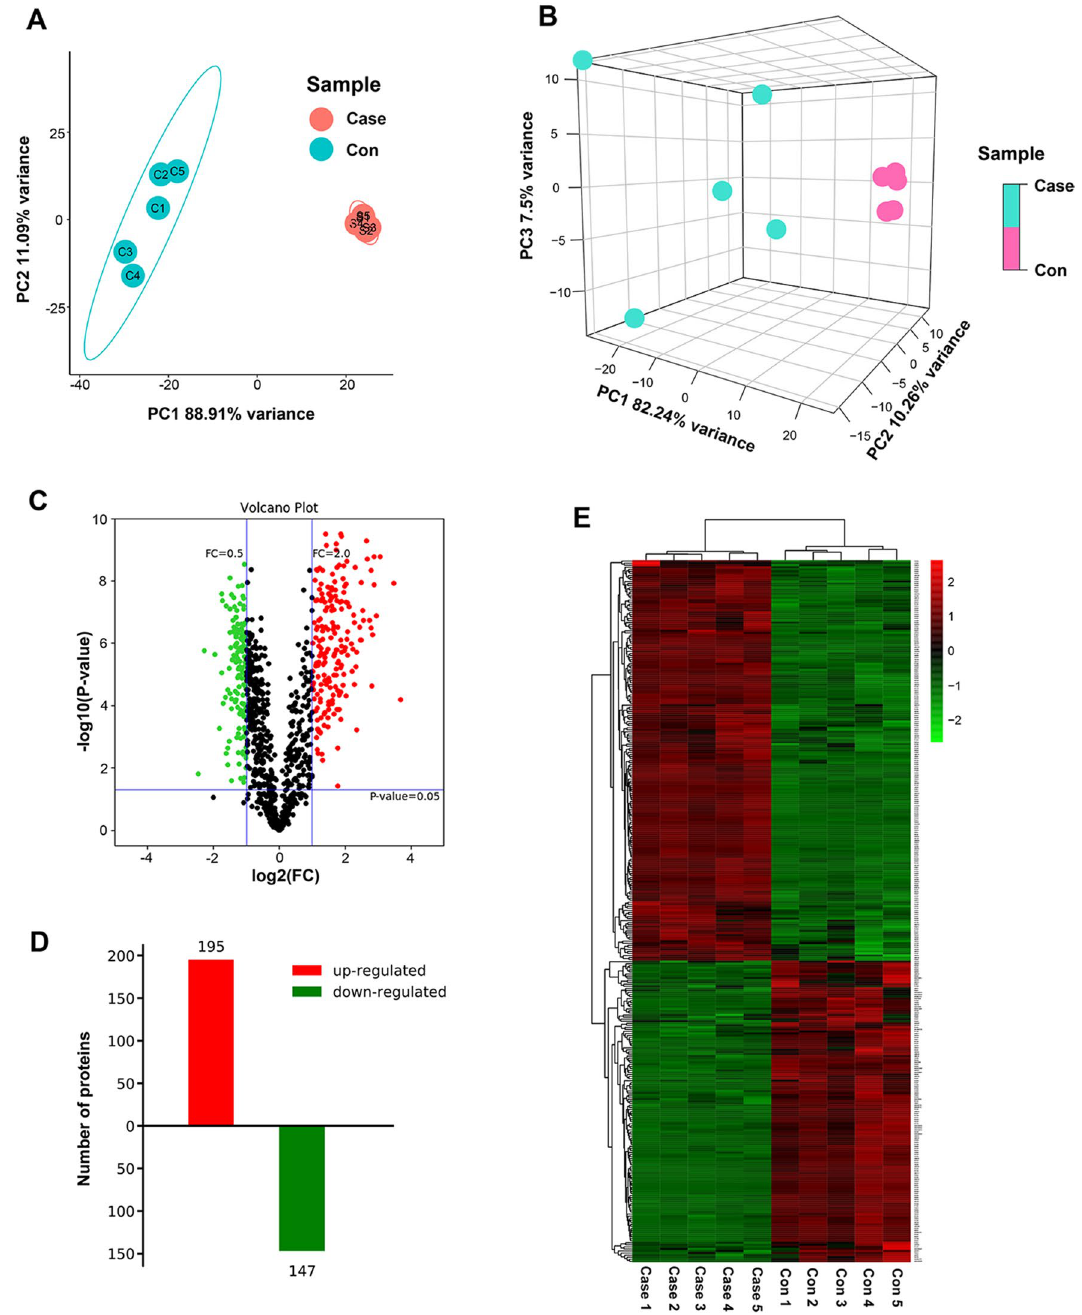
Figure 3. Proteomics analysis of the exosomes. ( A , B ) Principal component analysis of the individual samples. ( C ) The volcano plot of the differentially expressed exosome proteins between B-ALL patients and healthy controls. Green and red points represent downregulated and upregulated proteins, respectively. ( D ) Number of upregulated and downregulated differentially expressed exosome proteins in B-ALL patients compared with healthy controls. ( E ) Heatmap clustering of the differentially expressed exosome